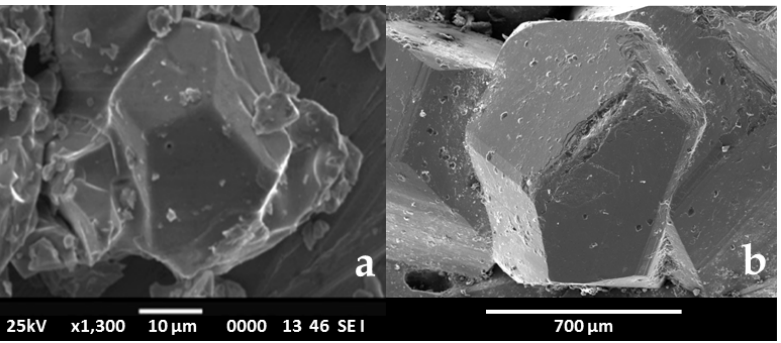
Figure 4. ( a ) Scanning electron microscopy image of an Al 62.2 Cu 25.3 Fe 12.5 quasicrystal with the shape of of an elongated dodecahedron (reproduction from [28]); ( b ) Scanning electron microscopy image an elongated dodecahedron (reproduction from [28]). ( b ) Scanning electron microscopy image of a limonitised pyrite with the approximate shape of an elongated dodecahedron, similar to the marcassite described by Romé de L’Isle [1].